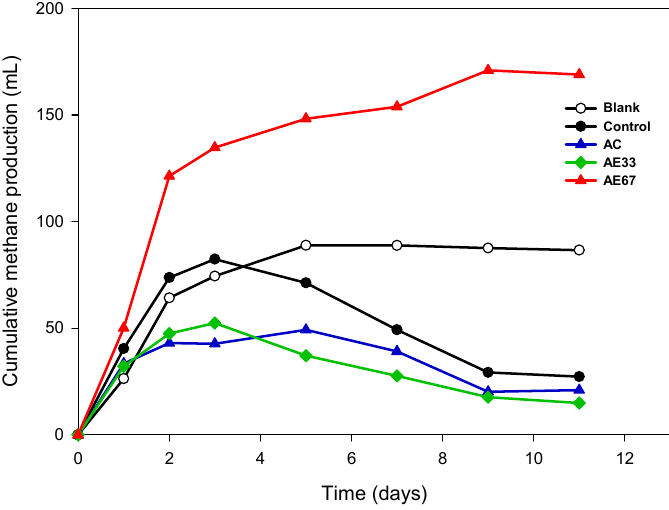
Figure4. Cumulative methane production fromthe intermediates of coal degradationin the anaerobicbatch